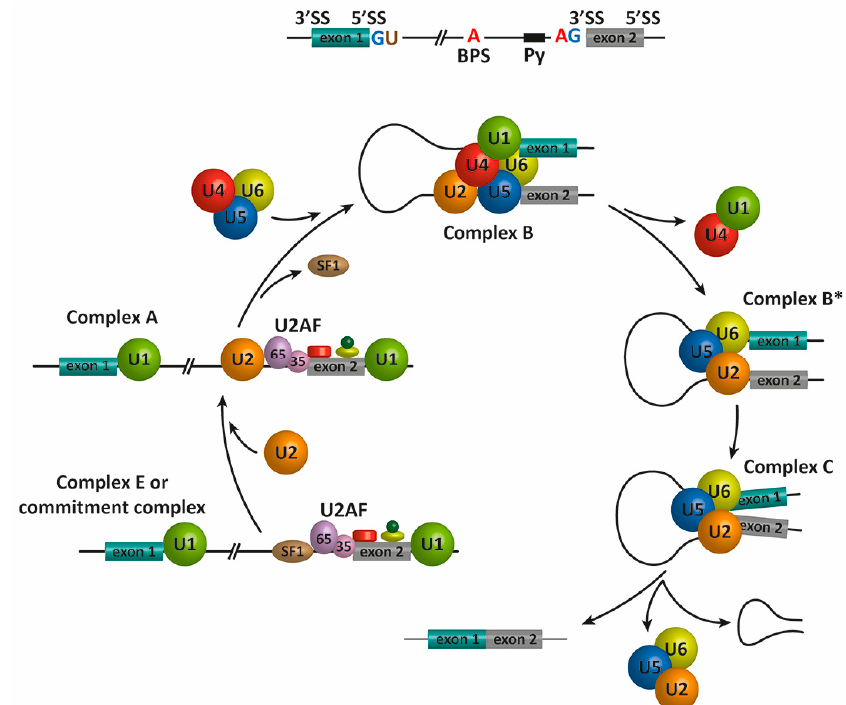
Figure 1. Schematic representation of the spliceosome assembly and pre ‐ mRNA splicing. In the first step of the splicing process, the 5 ′ splice site (GU, 5 ′ SS) is bound by the U1 snRNP, and the splicing factors SF1/BBP and U2AF cooperatively recognize the branch point sequence (BPS), the polypyrimidine (Py) tract, and the 3 ′ splice site (AG, 3 ′ SS) to assemble complex E [11,12]. The binding of the U2 snRNP to the BPS results in the pre ‐ spliceosomal complex A [13]. Subsequent steps lead to the binding of the U4/U5–U6 tri ‐ snRNP and the formation of complex B [14]. Complex C is assembled after rearrangements that detach the U1 and U4 snRNPs [15] to generate complex B*. Complex C is responsible for the two trans ‐ esterification reactions at the SS. Additional rearrangements result in the excision of the intron, which is removed as a lariat RNA, and ligation of the exons. The U2, U5, and U6 snRNPs are then released from the complex and recycled for subsequent rounds of splicing [16,17].